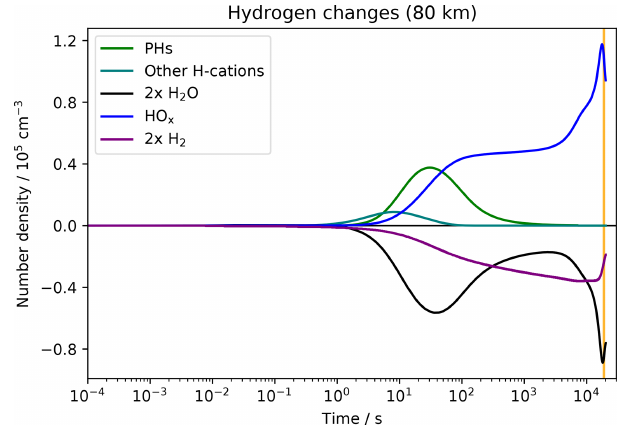
Figure 6. Modelled evolution of hydrogen-containing species at 75km altitude for RUN1. The solid lines show the sprite model run, and the dotted lines show a model run without electric fields applied. PHs denotes proton hydrates. The teal solid line depicts all hydrogen-bearing positive ions except for proton hydrates. Because of its large abundance, for water the absolute concentrations are not shown but the change of the concentration with respect to its ini- tial value is shown. The step-like changes of H 2 O are due to the transport simulations once every minute. The vertical orange line indicates the time of sunrise.